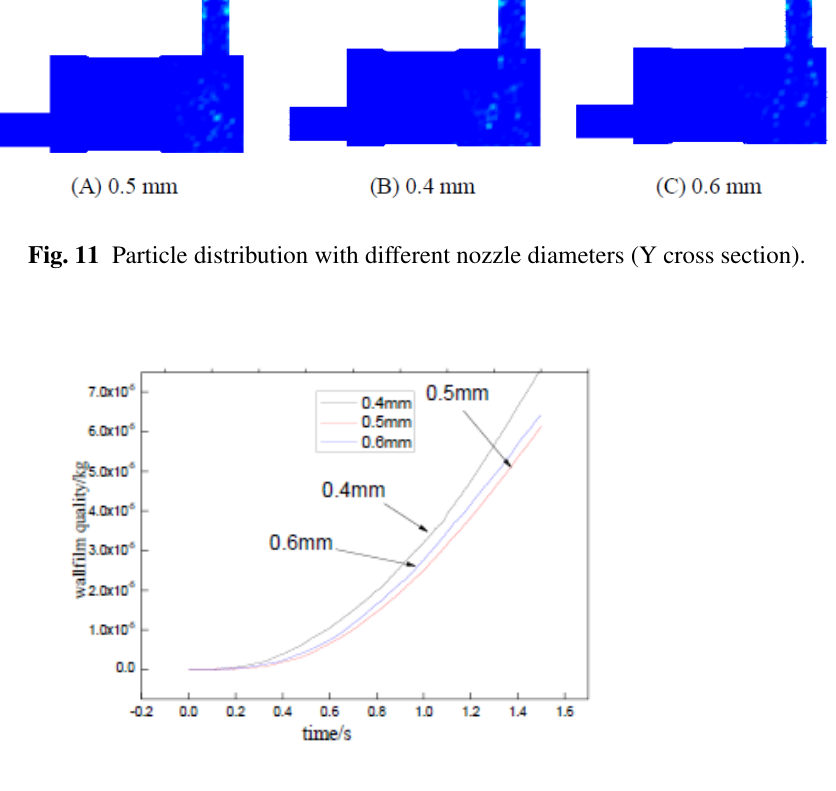
Fig. 12 Wall film mass comparison diagram under different nozzle